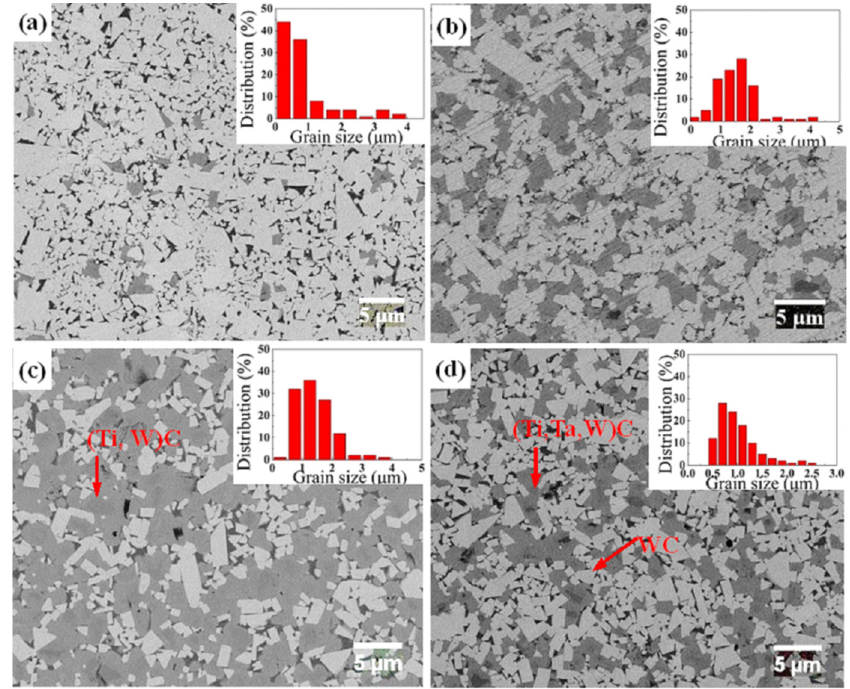
Figure 1. BSE micrograph of ( a ) WT1, ( b ) WT2, ( c ) WT3 and ( d ) WT4 cemented carbides.